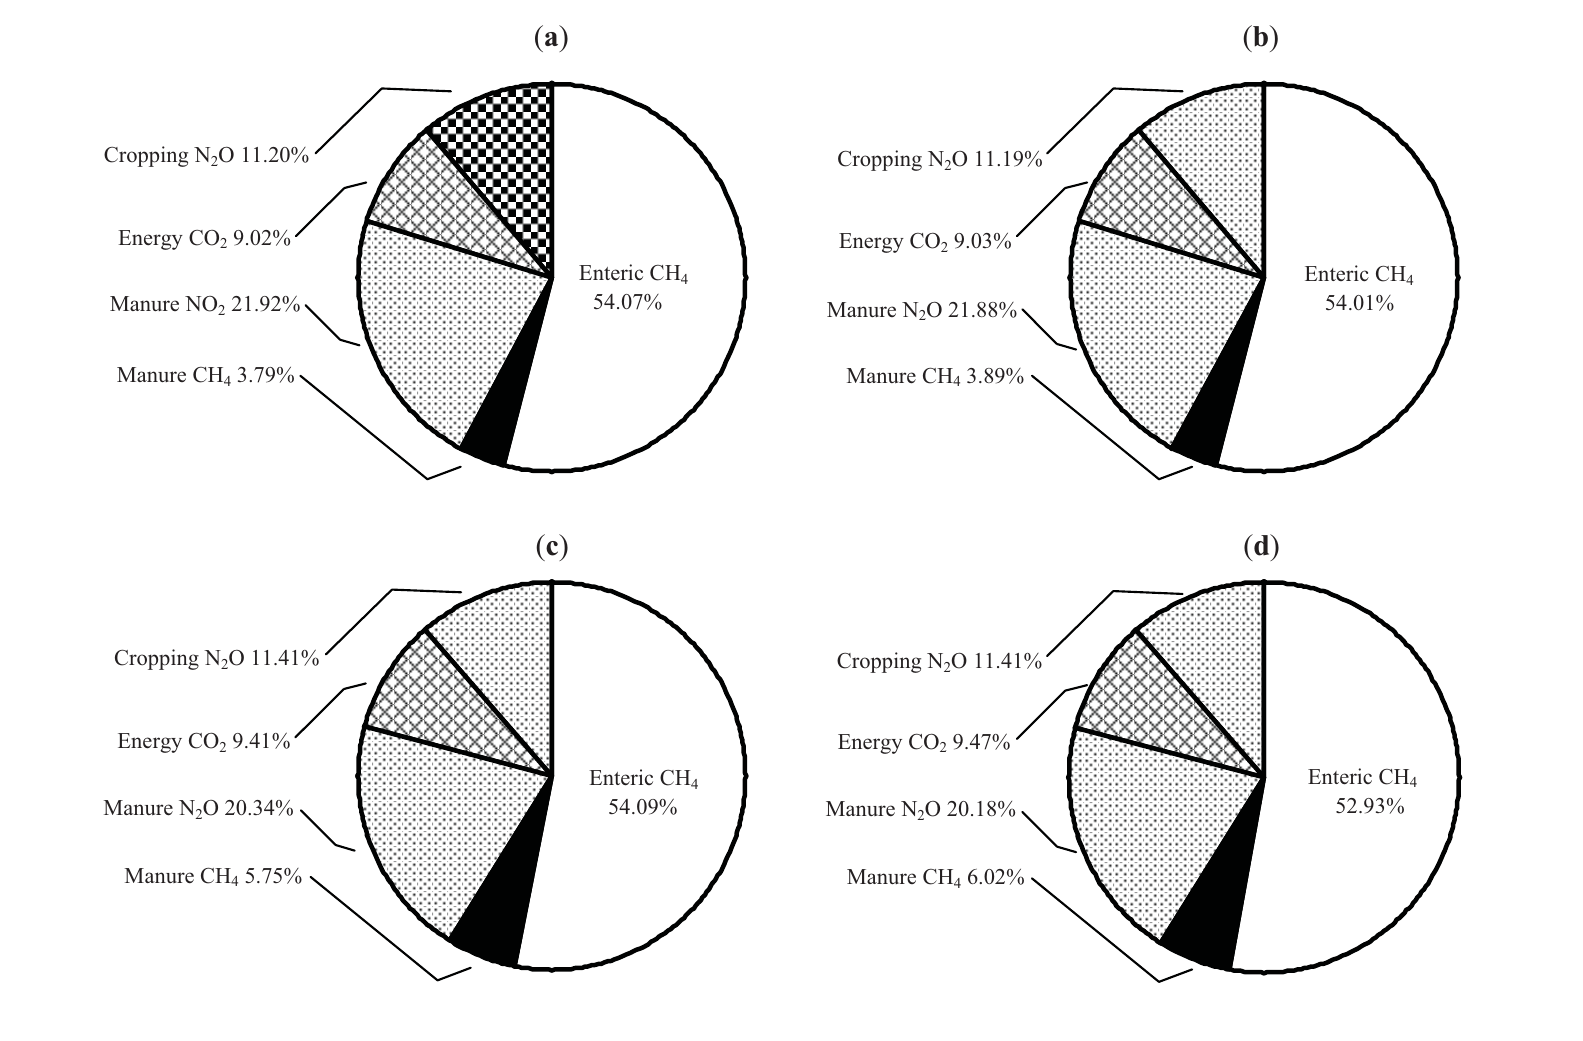
Figure 2. Breakdown of greenhouse gas emissions by source resulting from unimplanted and implanted calf-fed and yearling-fed beef production systems (CO ) equivalents; 160 cow-herd assumed). ( a ) Calf-fed, Hormone Free. ( b ) Calf-fed, Implanted. ( c ) Yearling-fed, 2 Hormone Free ( d ) Yearling-fed,